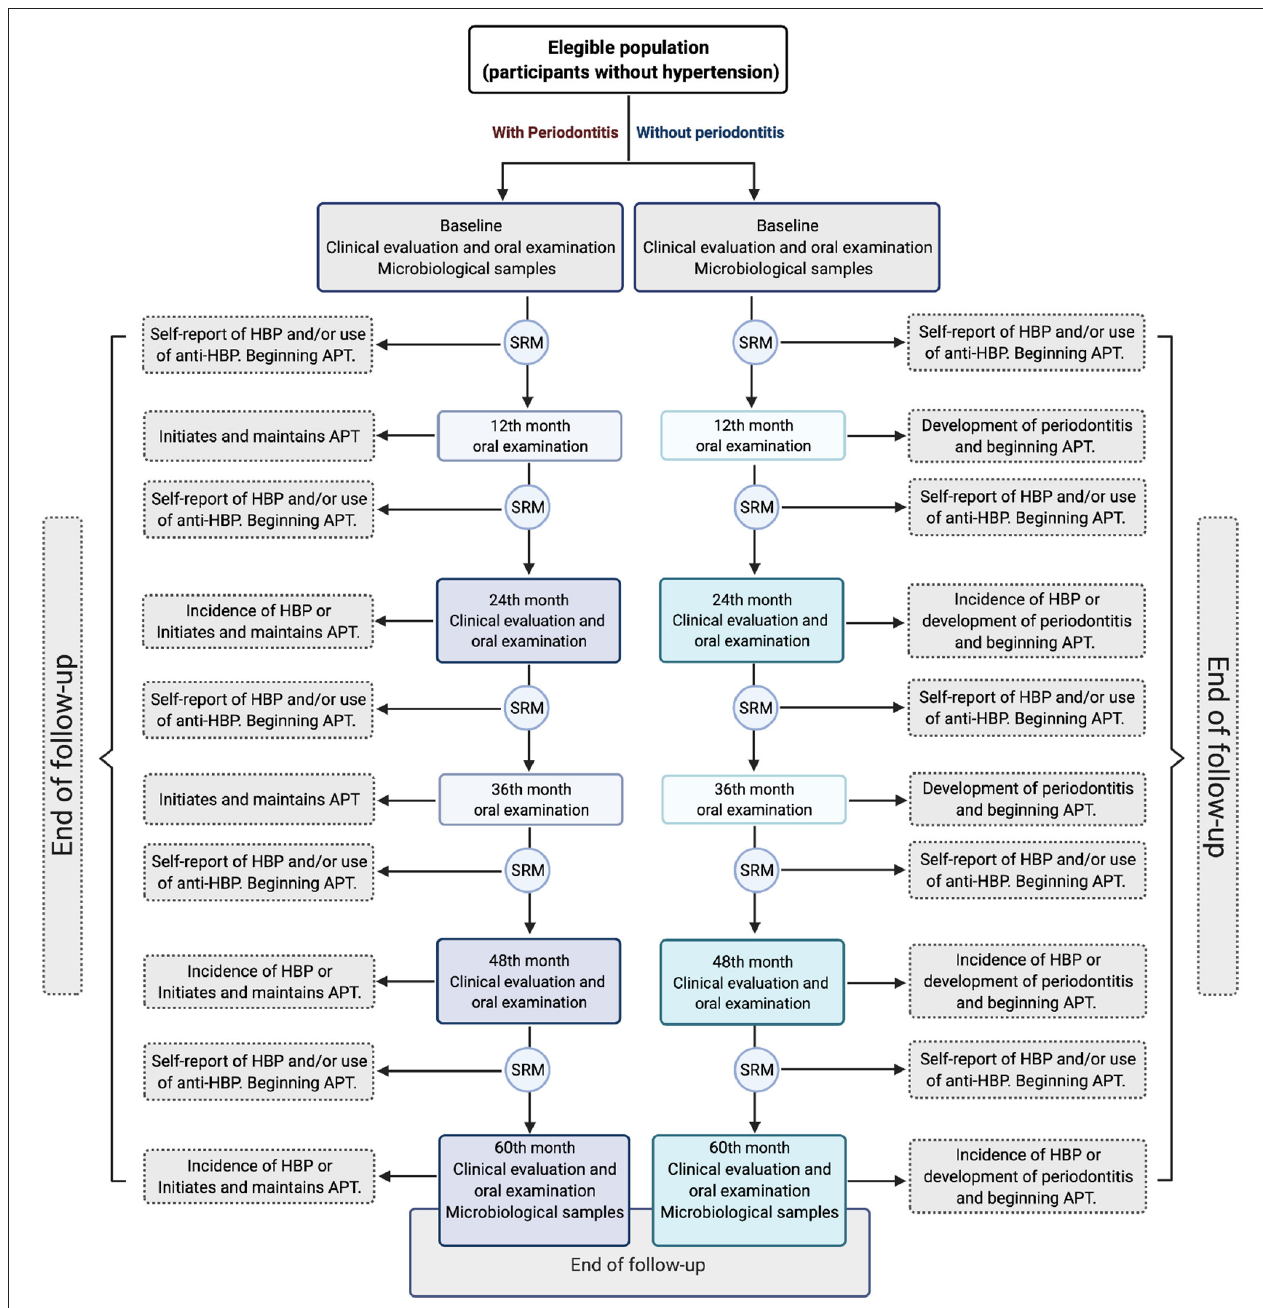
FIGURE 1 | Outline of the study 60-month follow-up. Different scenarios are presented according to the participant role. HBP , High blood pressure; SRM , Semiannual remote monitoring; APT , Active periodontal treatment. The image generated by the authors was created with the BioRender